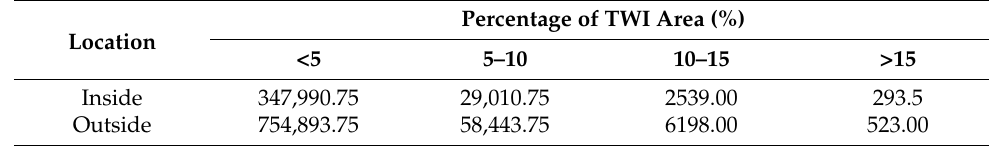
Table 10. Statistical results of the proportions of the inside and outside TWI areas of the pit rim